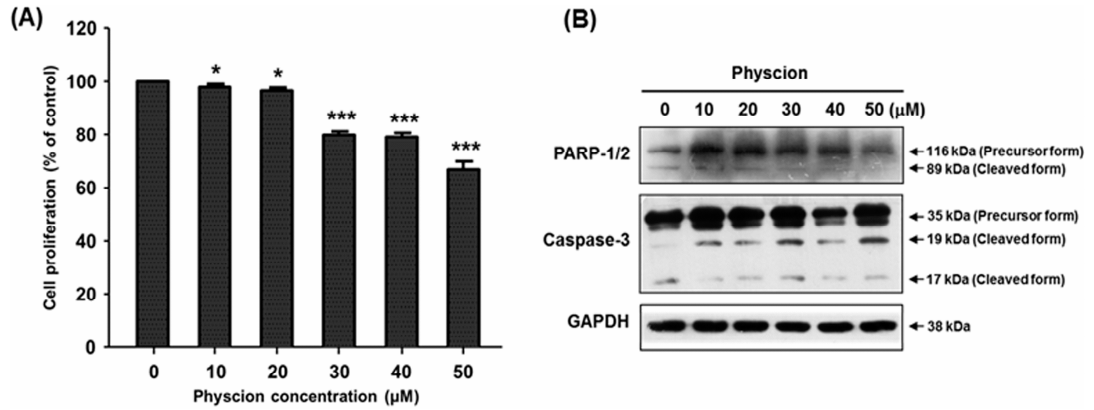
Figure 3. Effect of physcion on the viability and apoptosis of SK-N-BE(2)-C cells. ( A ) The cytotoxic effects of physcion on SK-N-BE(2)-C cells were examined using MTT assay. After 24 h incubation at various concentration of physcion, and cell viability was analyzed at 540 nm using an enzyme-linked immunosorbent assay (ELISA) plate reader (Bio-Rad, Hercules, CA, USA). The results represent the means ± SEM of three independent experiments. * p < 0.05 (compared with control); *** p < 0.001;